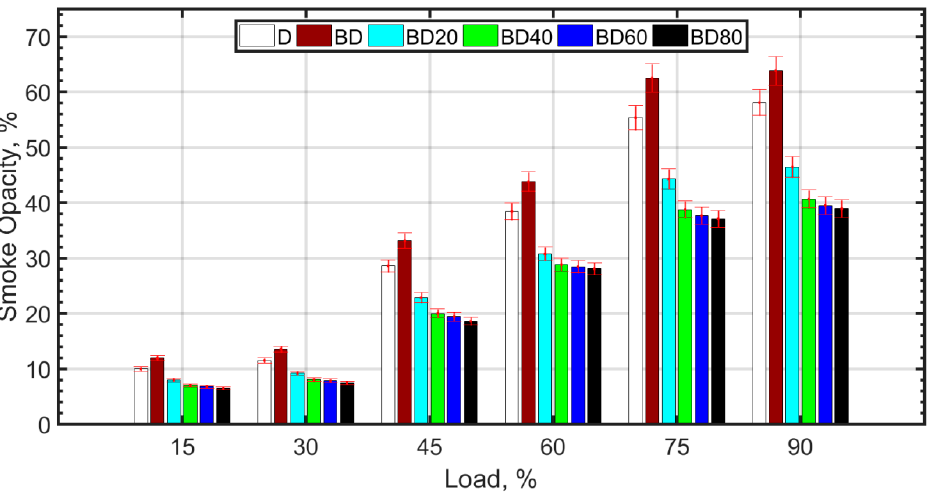
Figure 9. Smoke opacity variation with load.